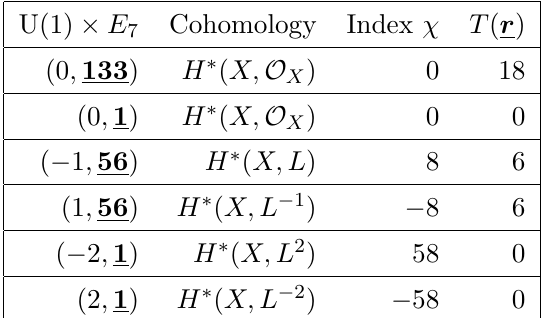
with a single line bundle 7